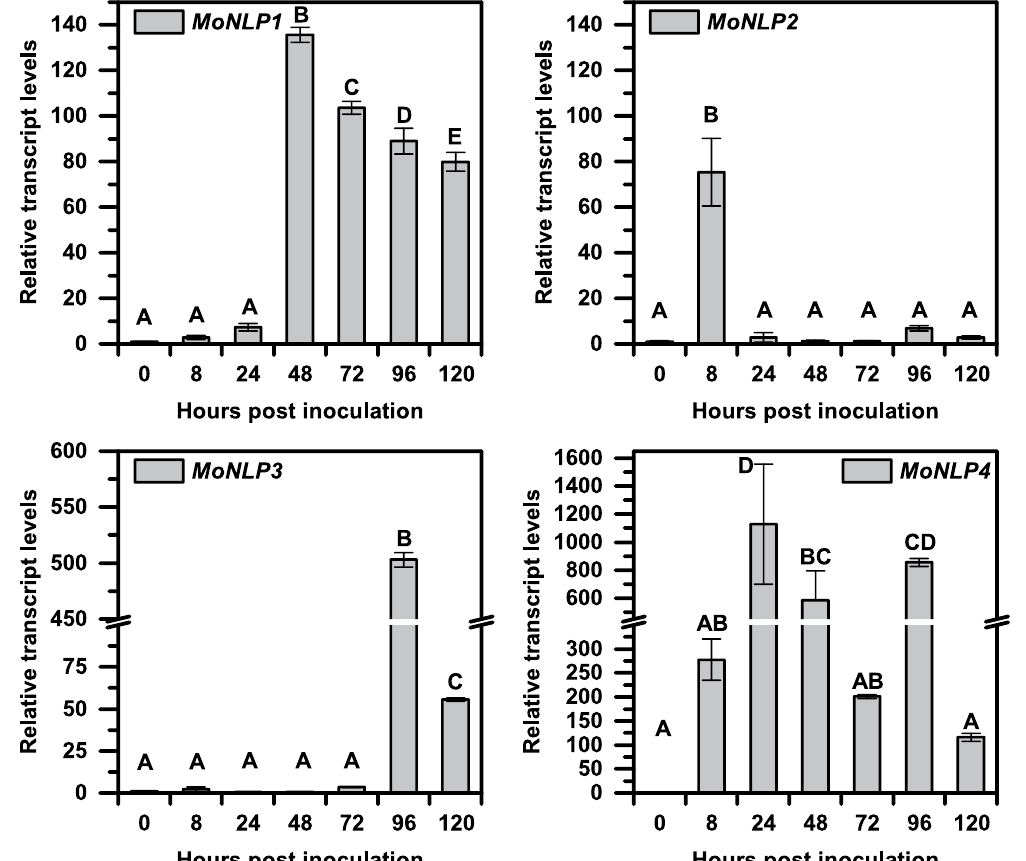
Figure 2. The relative transcript levels of MoNLP family are induced during infection of rice plants. Four-week- old rice plants were inoculated with M. oryzae , and samples were collected at indicated time points. The relative transcript levels of four MoNLP genes were determined by quantitative real-time polymerase chain reaction (q-RTPCR) using Actin and 40S ribosomal protein S3aE of M. oryzae as reference genes and normalized against levels at 0 hpi. The conidial inoculum was used as the 0-hour sample. Data shown are means ± sd of three replicates. Statistical differences among the samples are labeled with different letters (ANOVA, P < 0.01). The experiment was repeated twice with similar